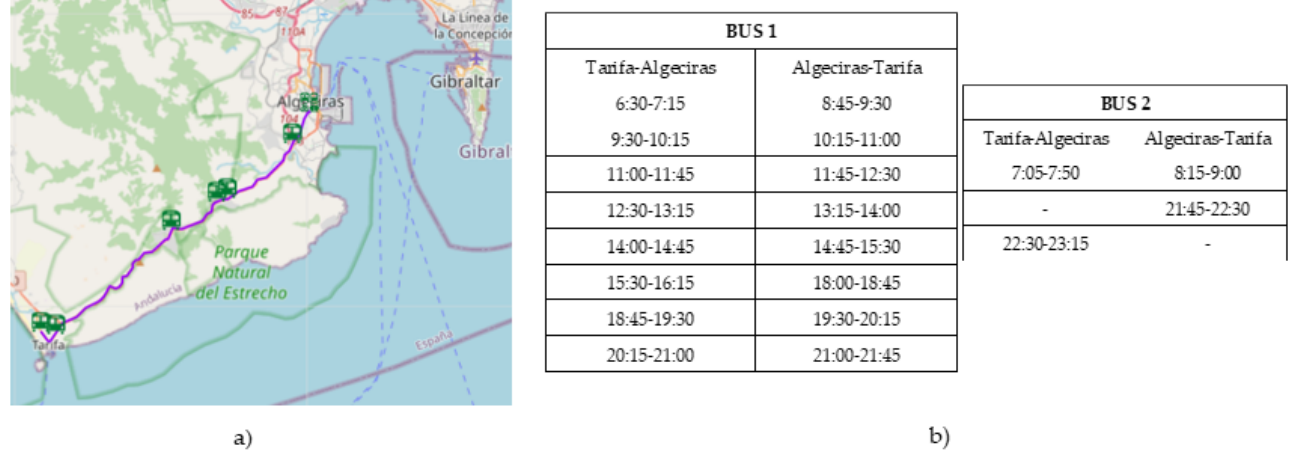
Figure 20. Line M-150: ( a ) route and ( b ) timetable of the employed buses.